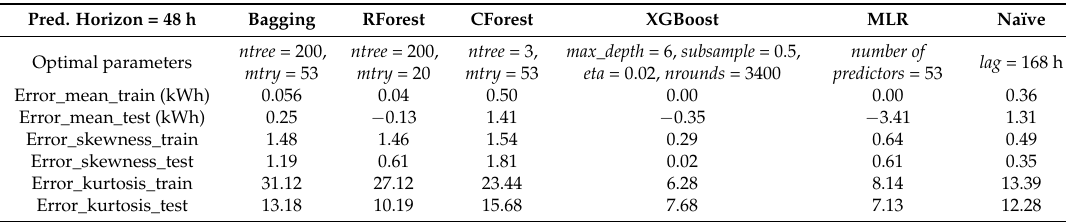
Table 5. Descriptive measures of the errors for each ensemble